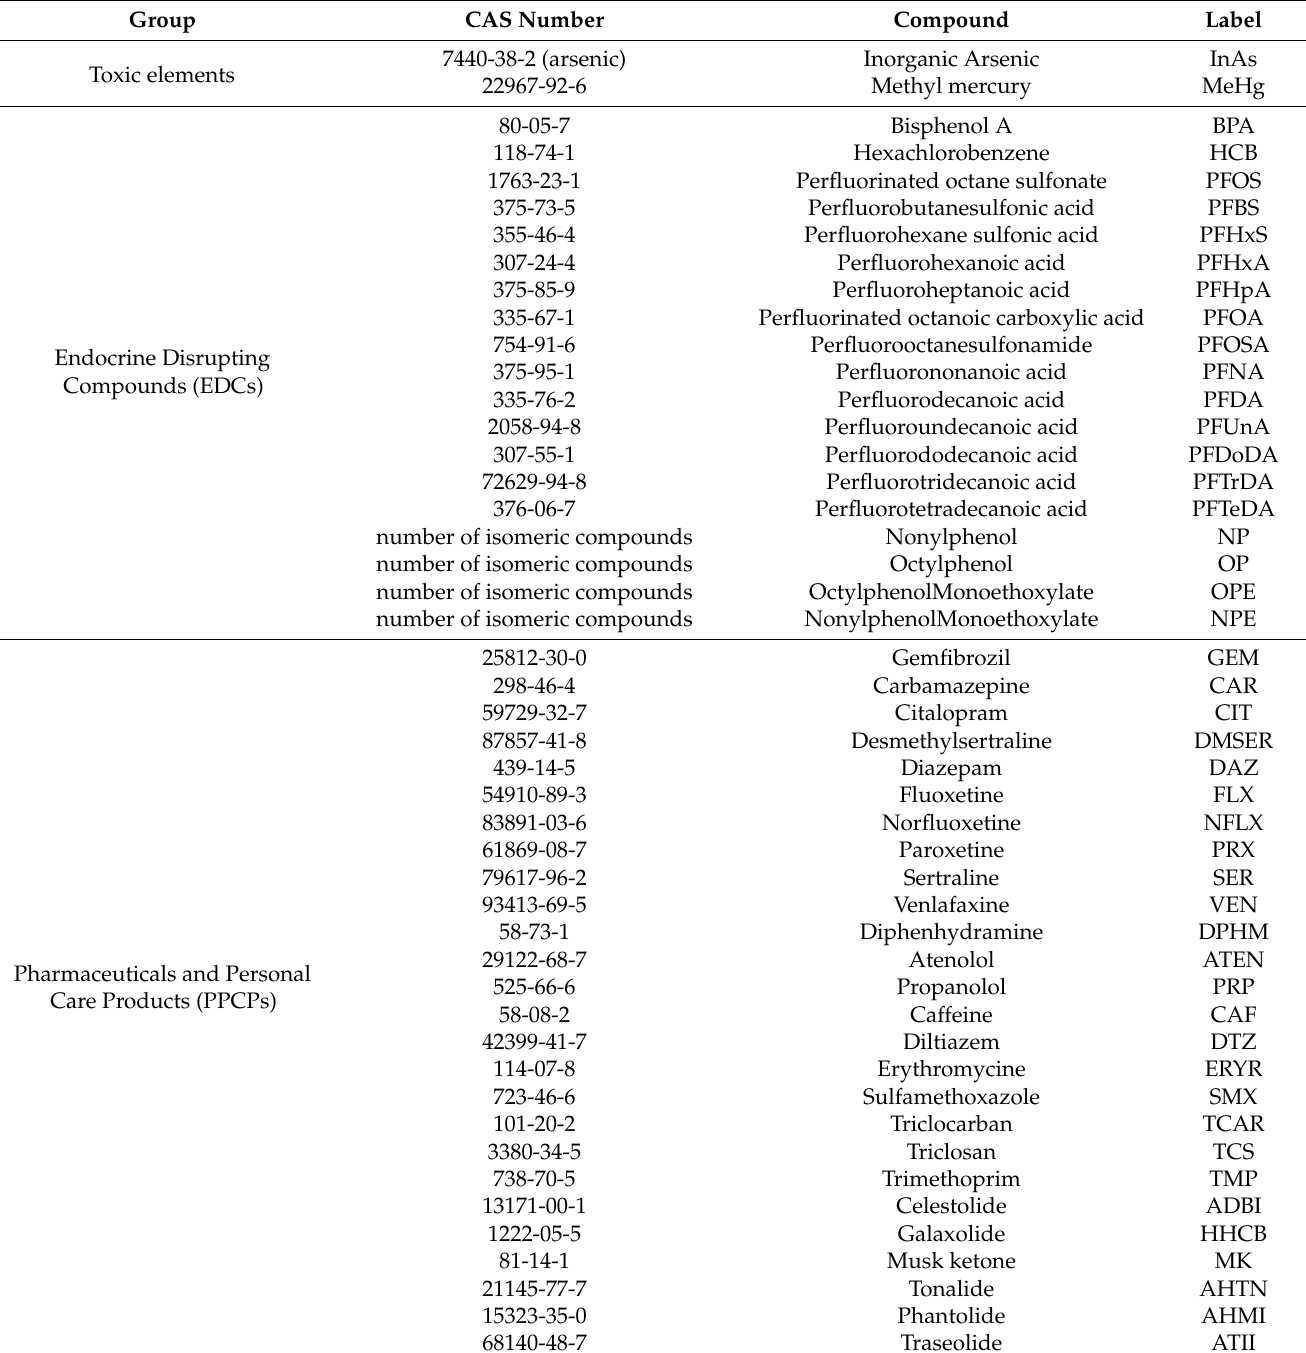
Table 1. List of emerging pollutants included in the risk